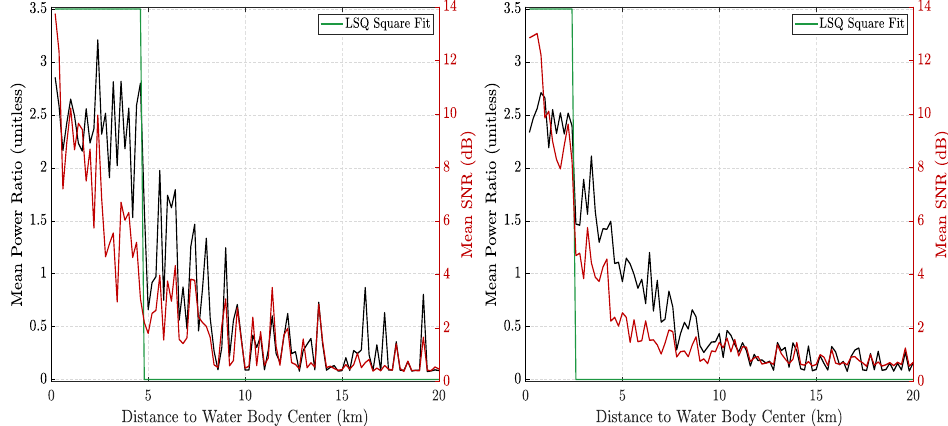
Figure 8. Test region latitude/longitude used in CYGNSS integration time analysis. Test region was centered around a 35 km long section of the Courantyne River between Guyana and Suriname.